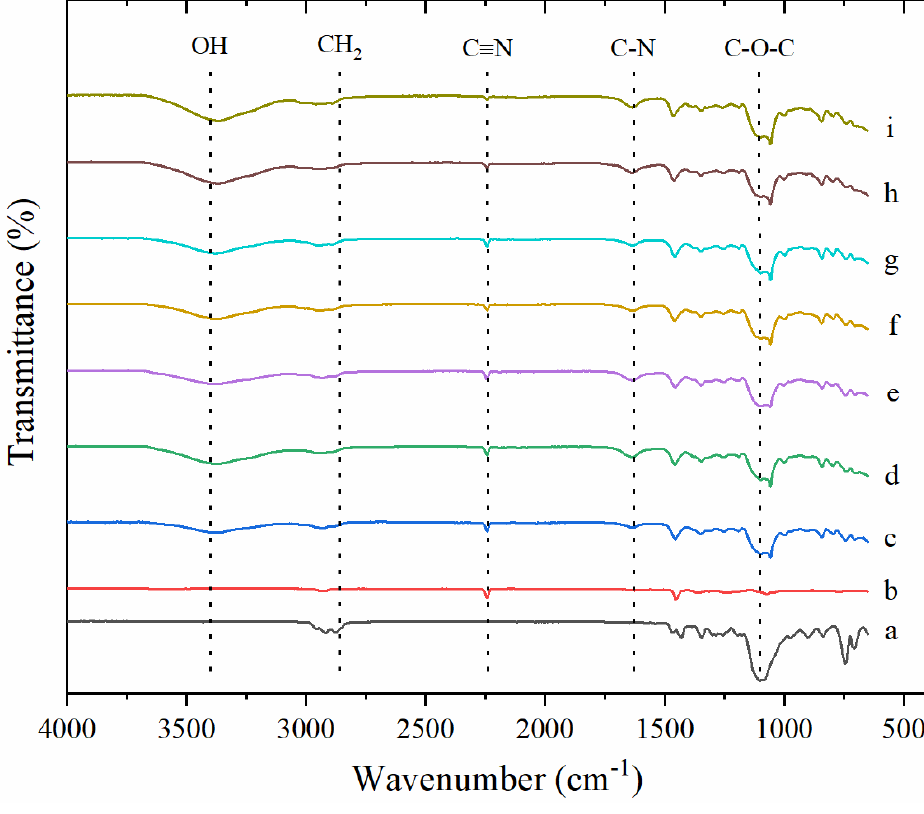
Figure 6. FTIR spectrums of samples ( a ) PECH ( b ) PAN ( c ) ER4-BR1.07 ( d ) ER2-BR1.07 ( e ) ER1.62- BR1.07 ( f ) ER1-BR1.07 ( g ) ER1.62-BR1.23 ( h ) ER1.62-BR1.5 ( i )